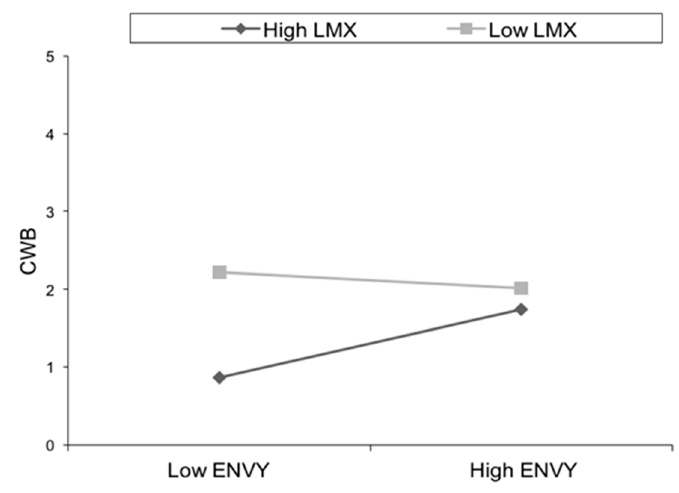
Figure 3. Interaction effects of LMX and envy on CWB. Note: LMX = Leader Member Exchange; CWB = Counterproductive Work Behavior.